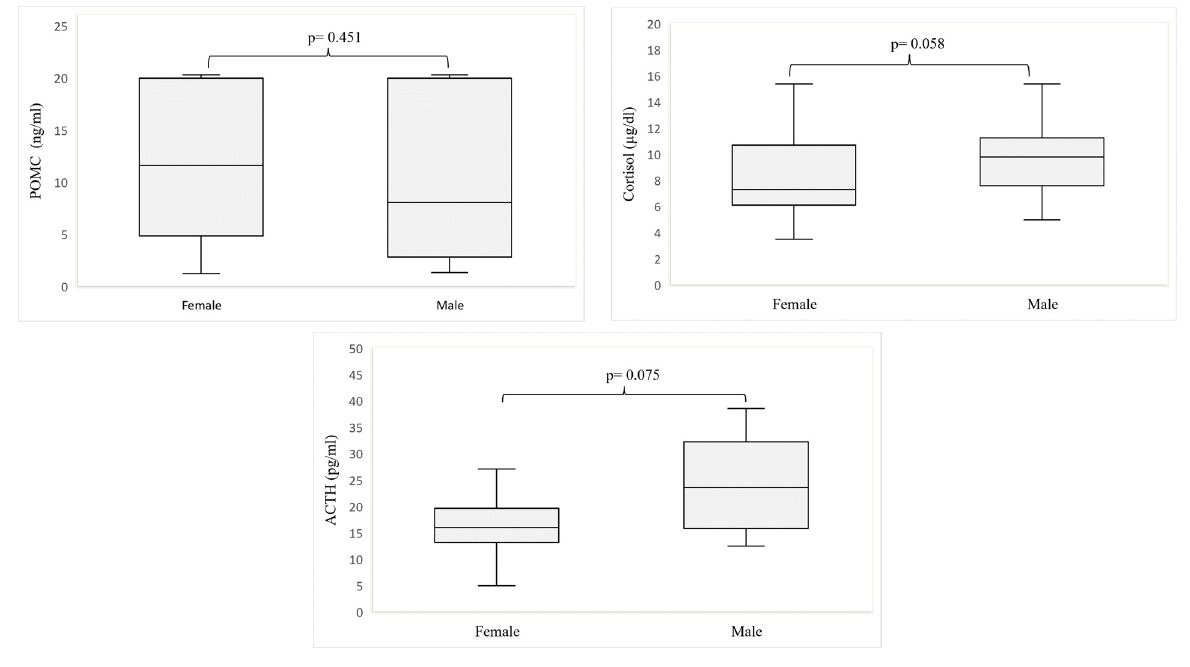
Figure 2. Hormone levels by sex of patients with fetal alcohol spectrum disorder. Abbreviations: POMC—proopiomelanocortin; ACTH—adrenocorticotropin. Comparisons between means were analyzed using Mann–Whitney U test.